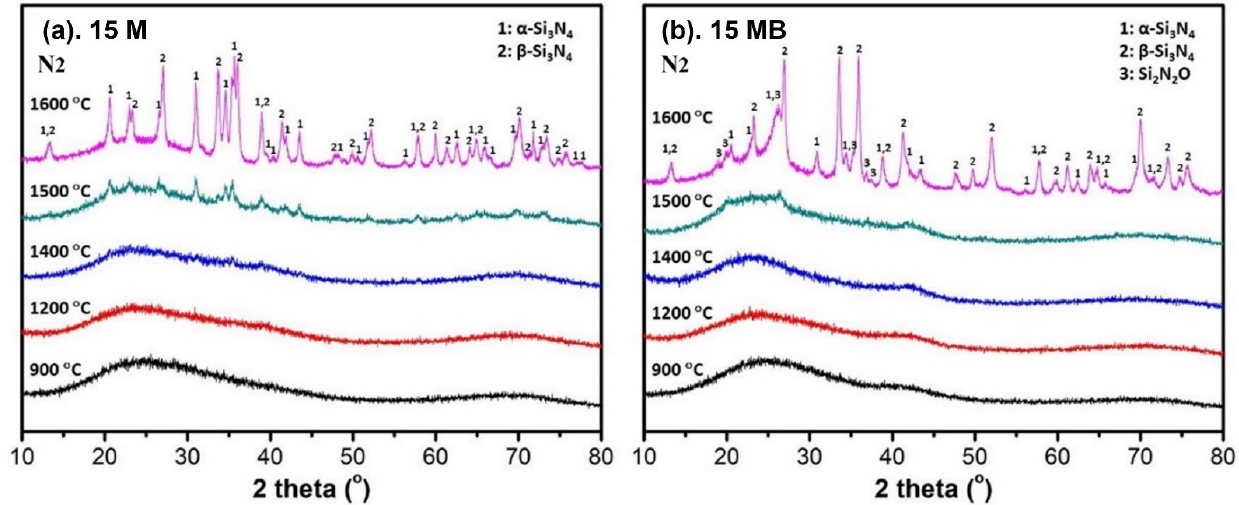
Figure 7. XRD spectra of the pyrolysis products of ( a )15 M and ( b )15 MB at different temperatures. Compared with 15 M, the ceramic products of 15 MB have no obvious diffraction peak after 1500 °C heat treatment, but the diffraction peak becomes obvious when the heat treatment reaches 1600 °C. According the analysis of the signal of the diffraction peak, the